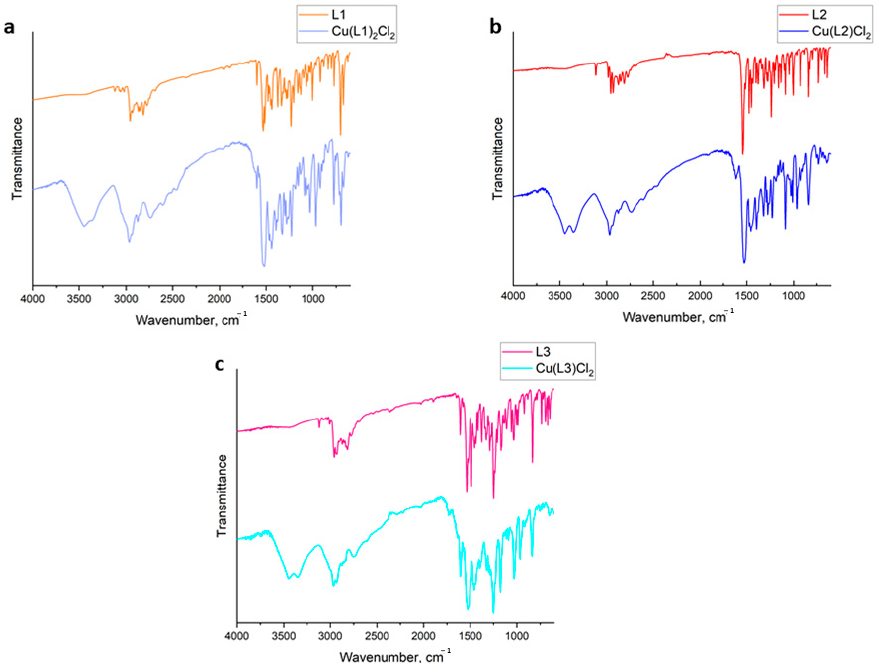
Figure 3. FTIR spectra of pure ligands and obtained complexes: ( a ) L1 and Cu(L1) 2 Cl 2 ; ( b ) L2 and Cu(L2)Cl 2 ; ( c ) L3 and Cu(L3)Cl 2 .